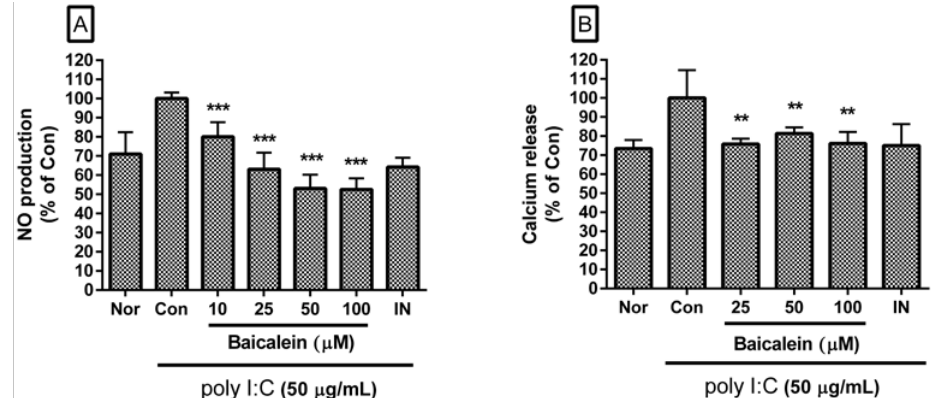
Figure 2. Effect of baicalein on NO production ( A ) and calcium release ( B ) by RAW 264.7 cells induced by poly I:C. The normal group (Nor) was treated with media only. The control group (Con) was treated with poly I:C (50 μg/mL) alone. IN: indomethacin (0.5 μM). Values are mean ± SD. ** p < 0.01 vs. Con; *** p < 0.001. poly I:C: polyinosinic–polycytidylic acid.